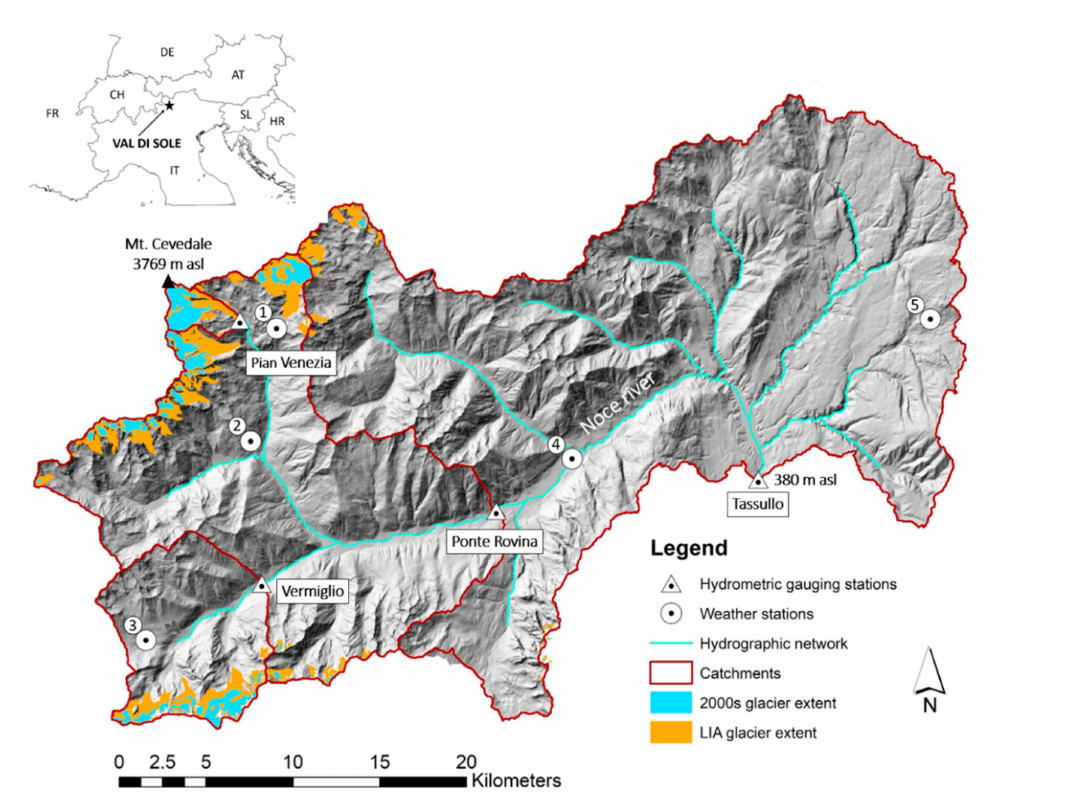
Figure 1. Geographical setting of the study area. Weather stations: (1) Careser Diga, (2) Peio, (3) Tonale, (4) Mal è , (5) Mendola.